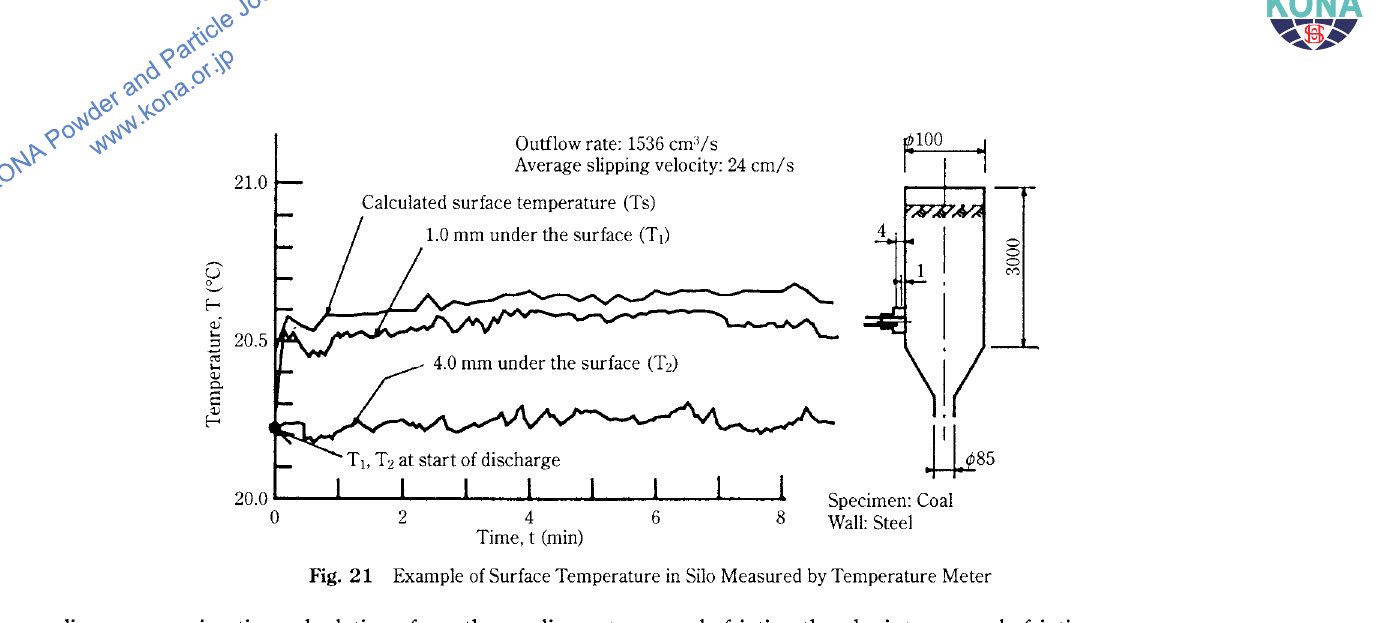
Fig. 21 Example of Surface Temperature in Silo Measured by Temperature Meter